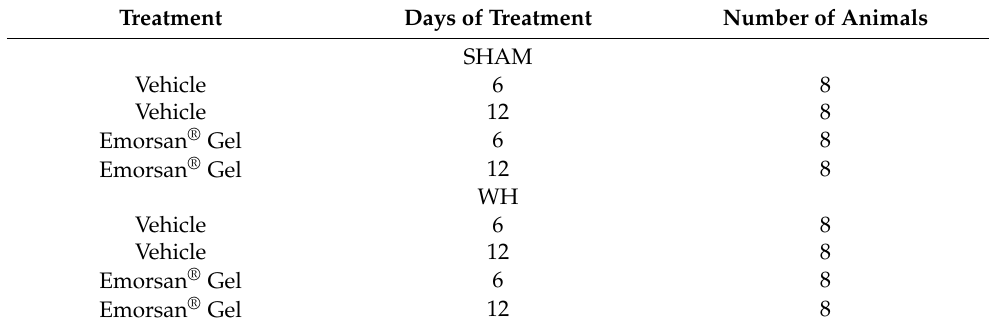
Table 1. Experimental